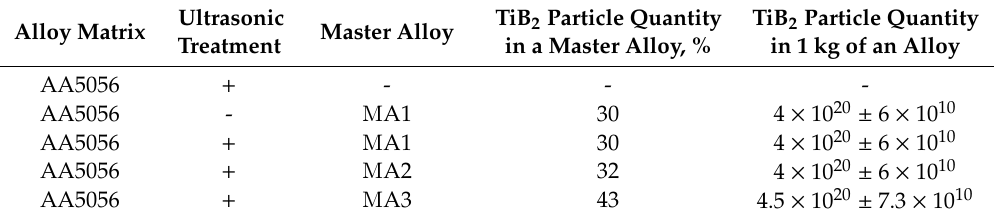
Table 2. A list of obtained